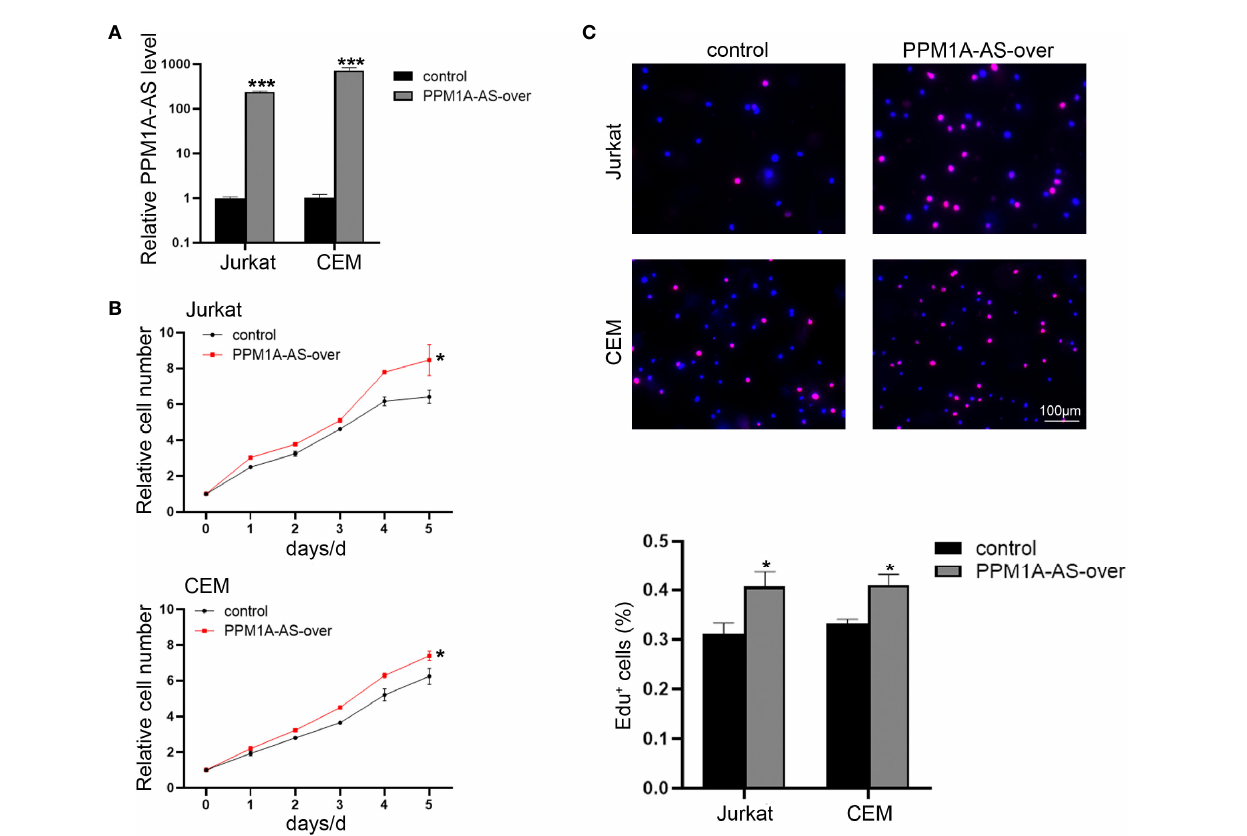
FIGURE 3 | Overexpression of lncRNA PPM1A-AS can promote cell proliferation. (A) The ef fi ciency of PPM1A-AS overexpression in Jurkat and CEM cell lines. (B) CCK-8 analyses of the proliferation rates of Jurkat and CEM cells infected with control or PPM1A-AS-overexpression lentivirus. (C) EdU analyses of the proliferative ability of Jurkat and CEM cells infected with control or PPM1A-overexpression lentivirus. Upper panel: representative images; bottom panel: average percentage of EdU + cells counted in each fi eld. Scale bar, 100 m m. Mean ± SD. *P < 0.05. ***P <